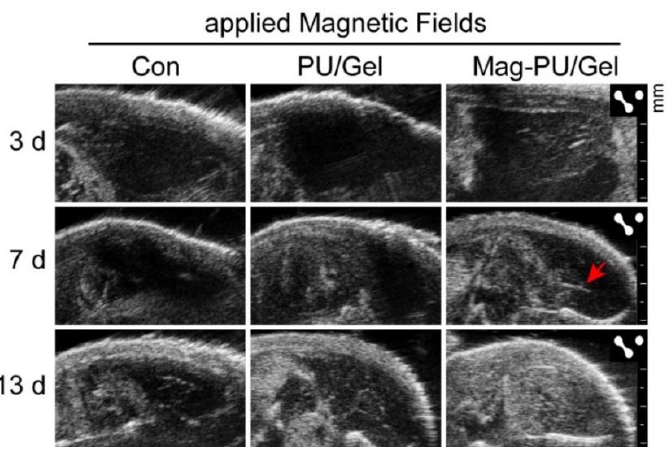
Figure 7. Ultrasonic imaging of the defected area of mice skeletal muscle on different days after the scaffold